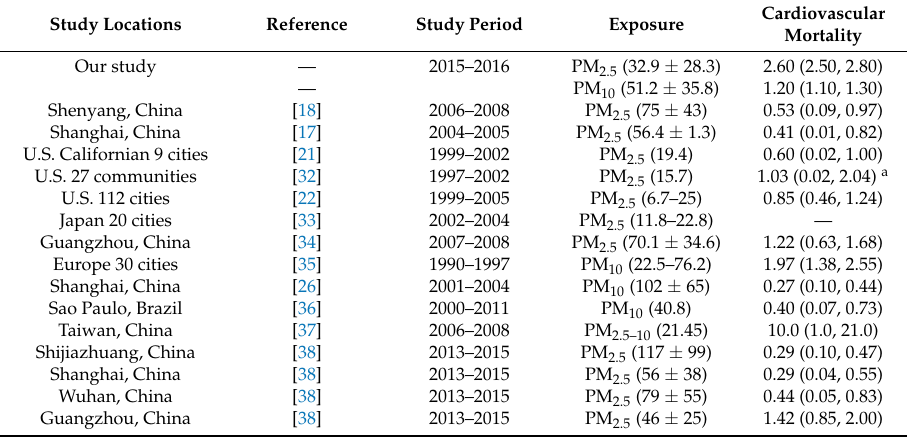
Table 6. Estimates of percent increase in mortality for 10 µ g/m 3 increment of PM 2.5 /PM 10 in multicity